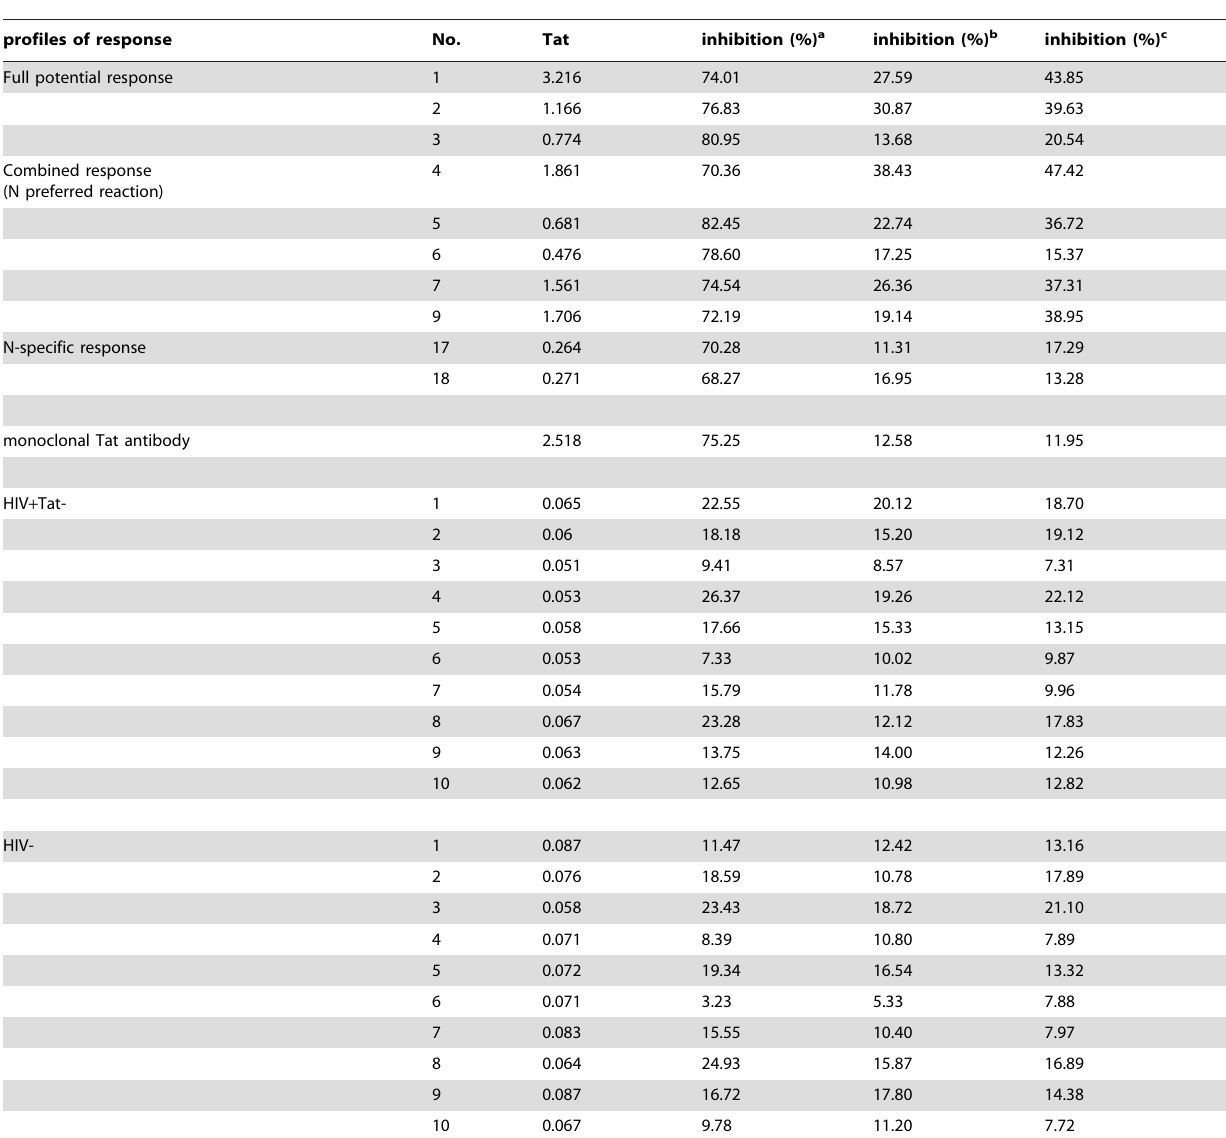
Table 1. Percent inhibition of Tat-transactivation after depleting anti-Tat antibodies and IgG fractions of the plasma.